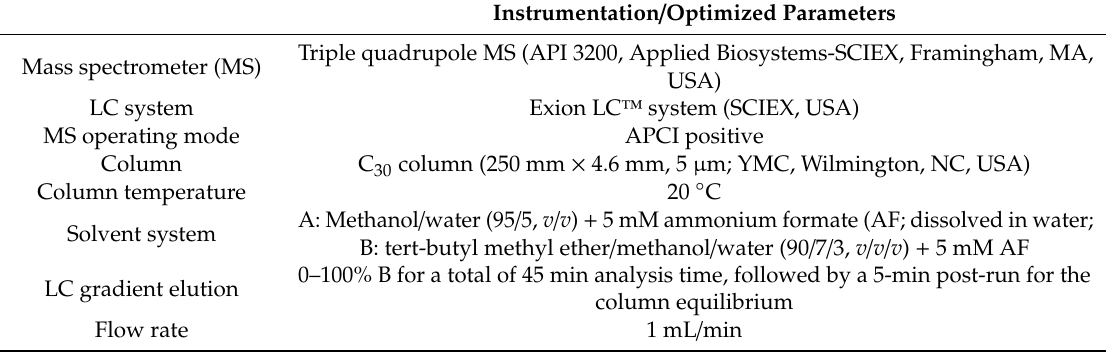
Table 3. The optimized values of collision energy (CE) and declustering potential (DP) of selected Q1 and Q3 MRM transitions for the simultaneous analysis of sterols and tocols using LC-MRM-MS / MS.